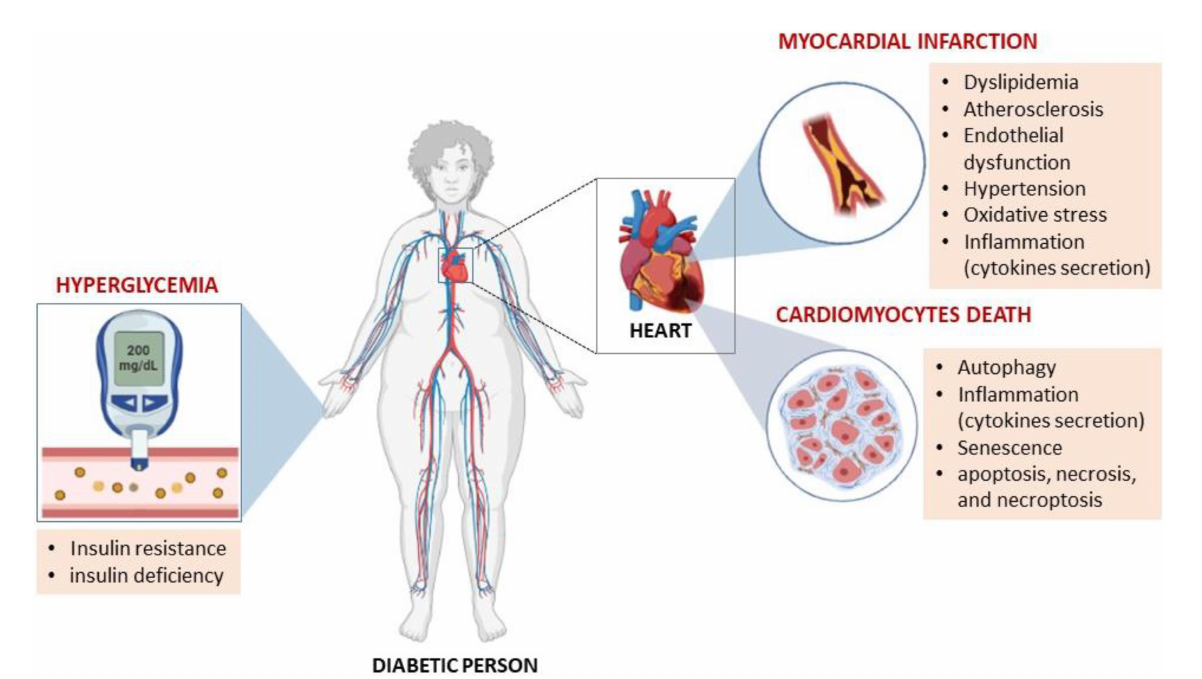
FIGURE1 Hyperglycemia, as a major characteristic feature of diabetes mellitus, is known be responsible for prompting metabolic abnormalities that make an individual susceptible to increased cardiovascular disease (CVD)-risk. For example, abnormal levels of serum lipids (dyslipidemia) that may eventually cause atherosclerosis through endothelial dysfunction are all implicated in the development of CVDs. Similarly, preclinical studies have implicated pathological mechanisms such as abnormal autophagy and inflammation to be involved in this